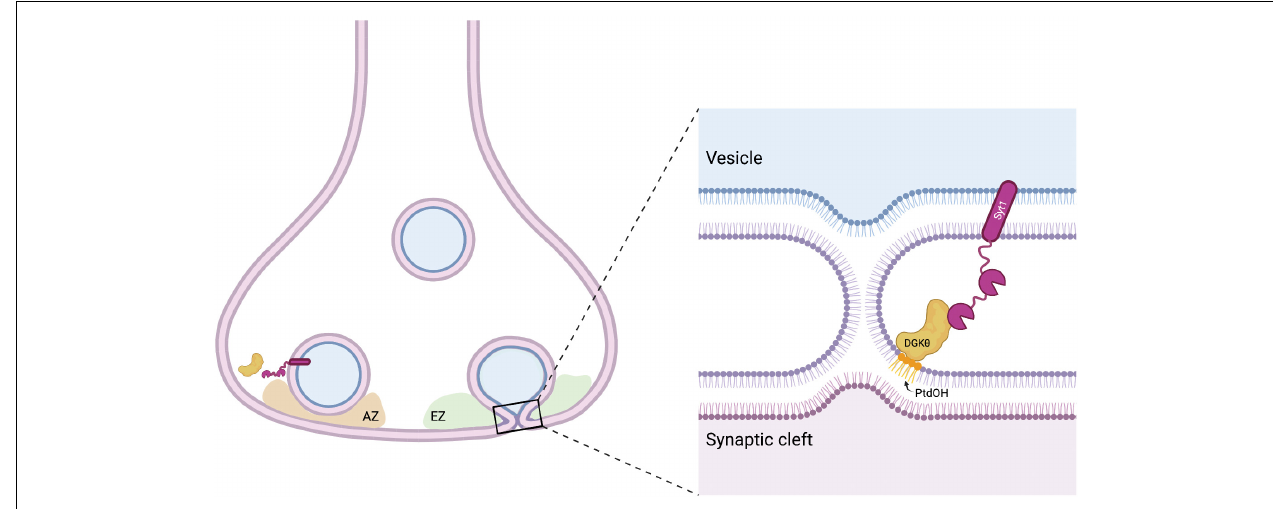
FIGURE 6 | Model for DGK θ ’s interaction with Syt1. Syt1 is a transmembrane protein on synaptic vesicles and the presynaptic membrane. Perhaps to aid in the membrane deformation required in the fusion and fission of vesicles, Syt1 binds to DGK θ and stimulates its kinase activity, producing local hotspots of PtdOH that generate negative membrane curvature. AZ = active zone, EZ = endocytic zone. Figure made with